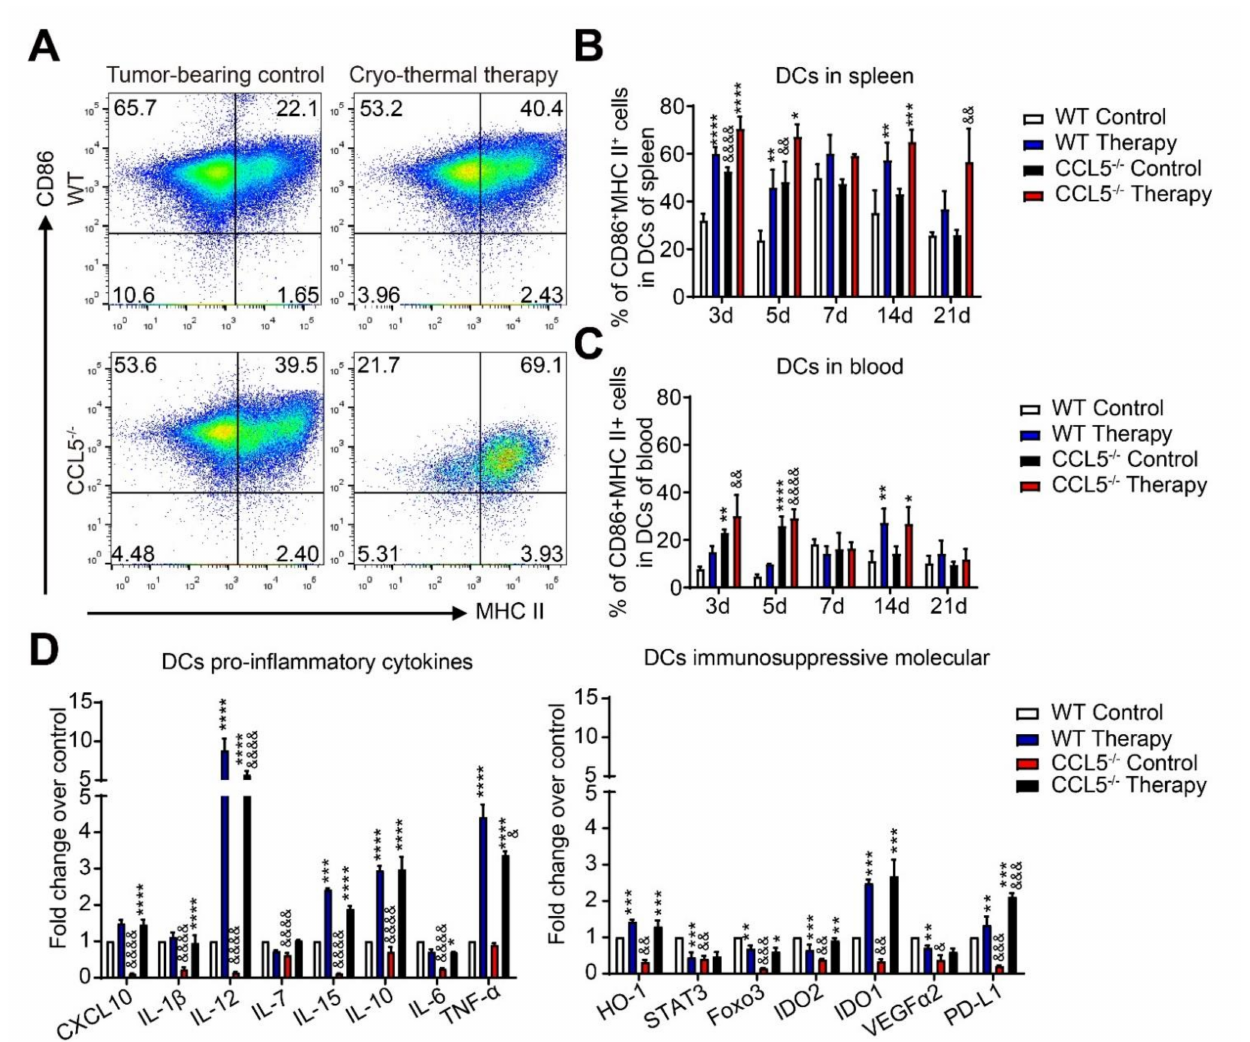
Figure 2. CCL5 deficiency enhanced the phenotypic maturation of DCs at an early stage after therapy. ( A ) Gating strategy of mature DCs. The percentages of mature DCs in the spleen ( B ) and blood ( C ) were evaluated at the indicated time points (3, 5, 7 and 21 d after treatment). ( D ) The expression of the immune-response-related molecules of DCs were detected with qRT-PCR. Total RNAs were isolated from splenic CD11c + DCs in treated mice or control mice. n = 4 per group; mean ± SD. The data of FACS were analyzed with FlowJo 7. * p < 0.05; ** p < 0.01; *** p < 0.001; **** p < 0.0001, compared to WT tumor-bearing control or CCL5 − / − tumor-bearing control. & p < 0.05; && p < 0.01; &&& p < 0.001; &&&& p < 0.0001, compared to WT